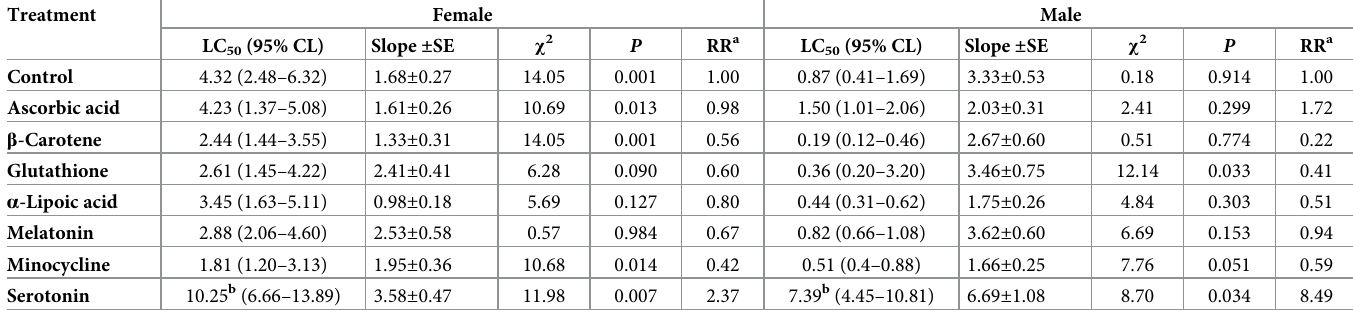
Table 2. LC 50 ( μ g vial/DDT) values with 95% confidence limits (CL), slope, χ 2 , and resistance ratio (RR) for D . melanogaster Canton-S adult females and males fed on the indicated antioxidants.